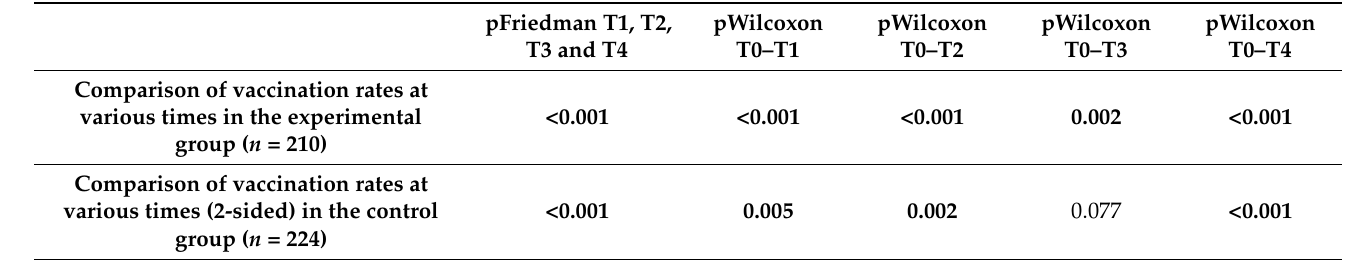
Table 3. Results of the Friedman test for significant changes in vaccination rates from T0 to T4 and the Wilcoxon tests between the various time points.